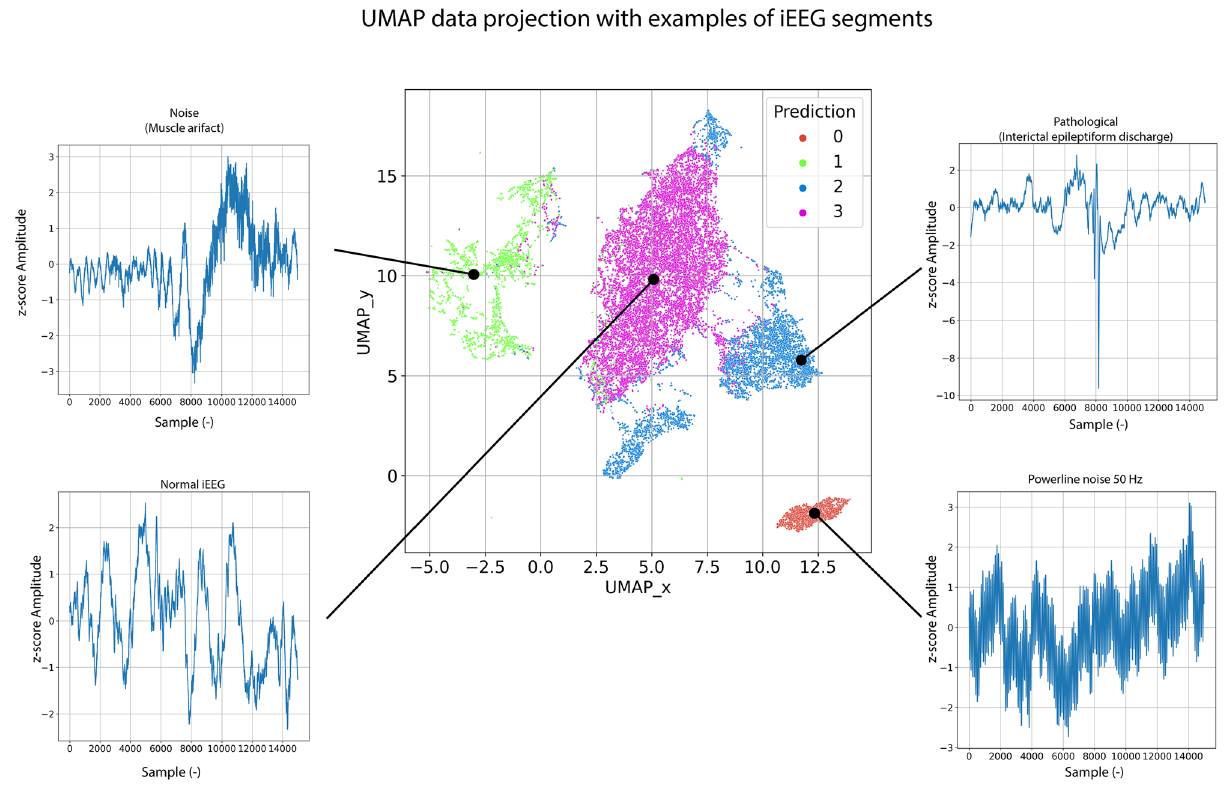
Figure 8. UMAP data projection with examples of iEEG segments from different clusters. The classes are ordered as follows: 0-Power line noise, 1-Artifacts, 2-Pathological Activity, 3-Physiological